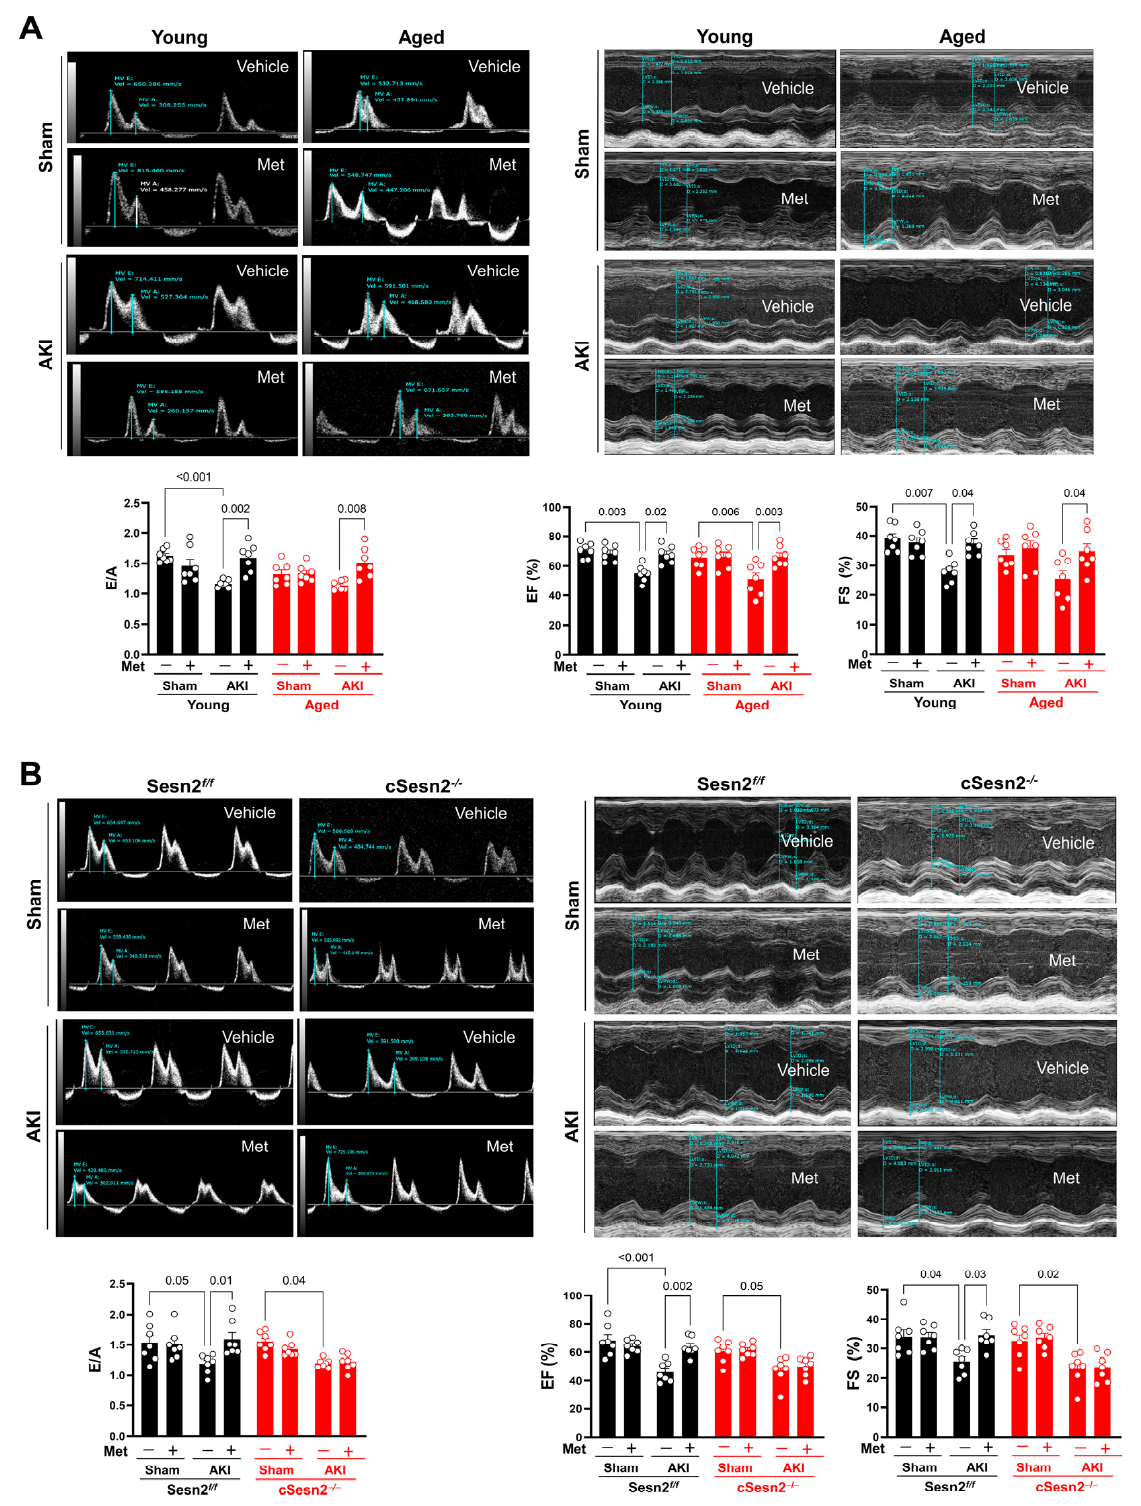
Figure 3. Evaluation of cardiac function through echocardiograms. ( A ) Diastolic function (E/A) and systolic function (LVEF and LVFS) of aged and young mice. ( B ) Diastolic and systolic functions of Sesn2 f/f and cSesn2 − / − mice. Means ± SEM; n = 7 per